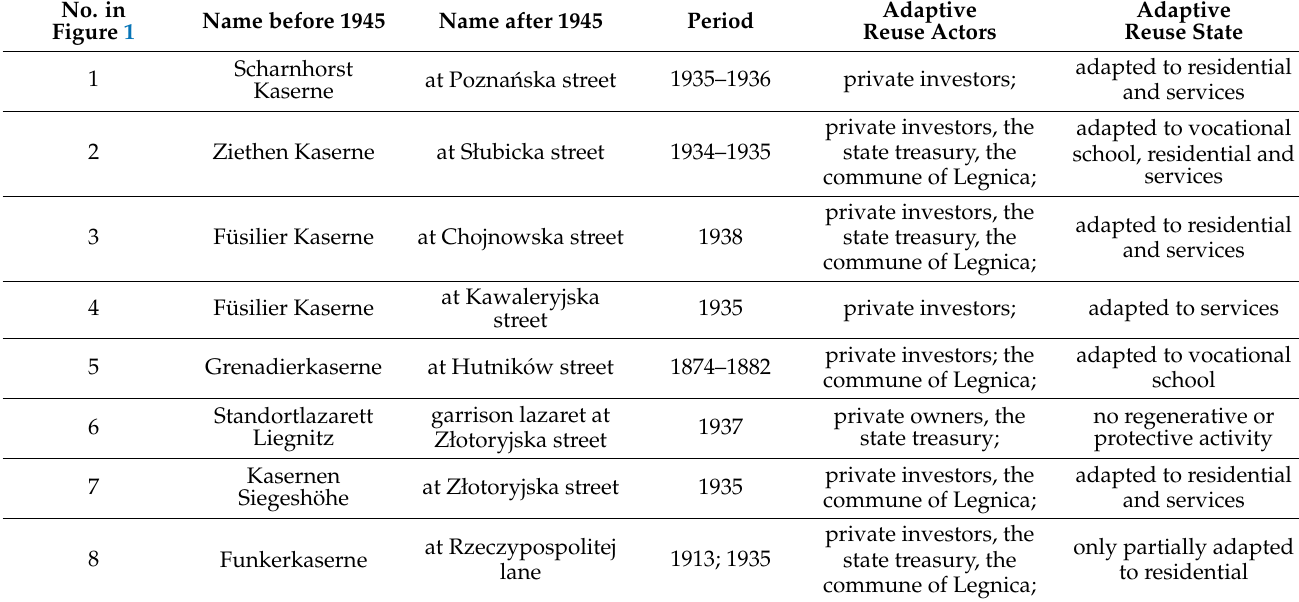
Table 3. The list of barracks in Legnica with information on adaptation and newly introduced functions of the regenerated objects (numbers relate to barracks indicated in Figure